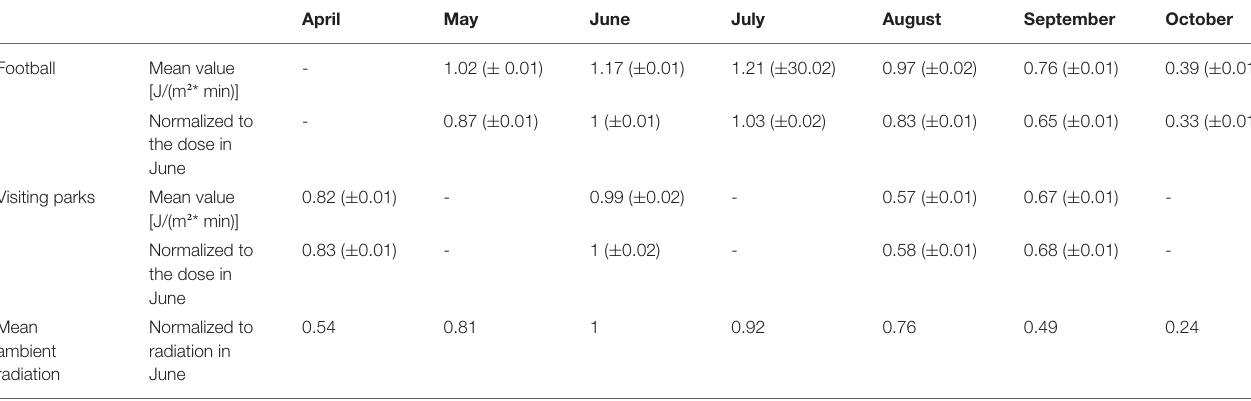
TABLE 1 | Mean UV exposure doses per minute for both activities in every month together with their standard error values and total mean values.